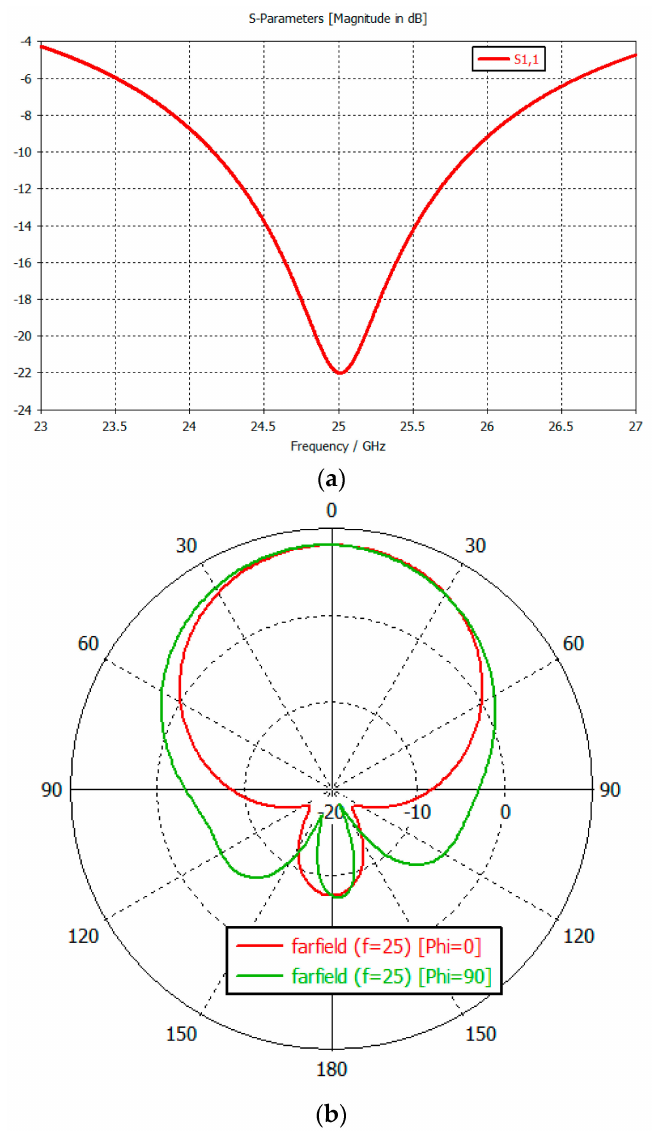
Figure 5. ( a ) Single radiator Microstrip Planar Antenna input reflection. ( b ) Single radiator Microstrip Planar Antenna radiation